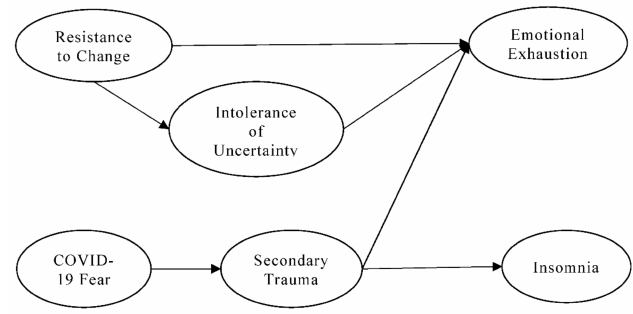
Figure 1. Conceptual